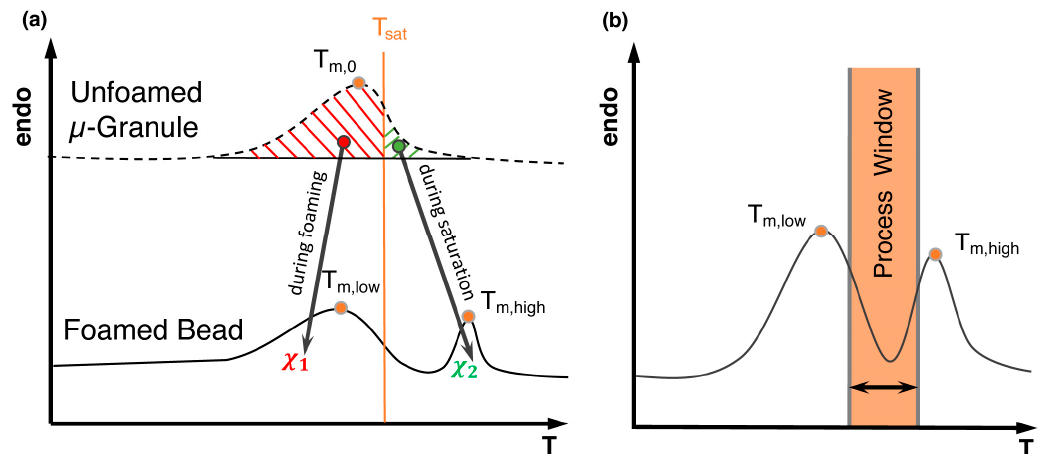
Figure 10. Sketch of ( a ) double melt peak development, and ( b ) process window for fusion in steam chest molding based on References [237,259] .